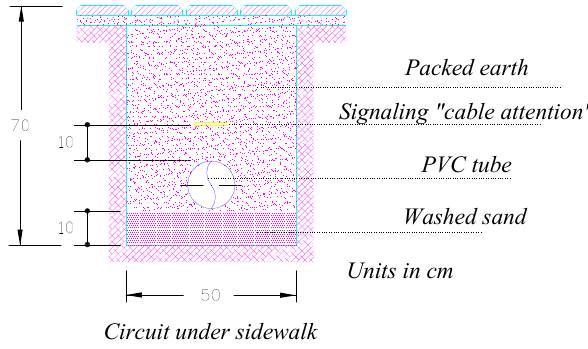
Figure 2. Example of underground distribution grid.